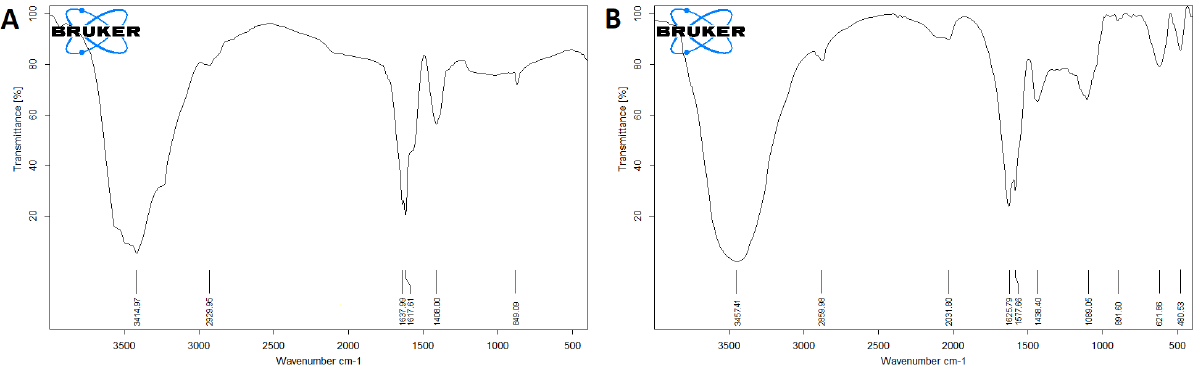
Figure 4. ATR-FTIR Spectra of CS-GEL (A) and CS-GEL/58SBG-NPs (B)